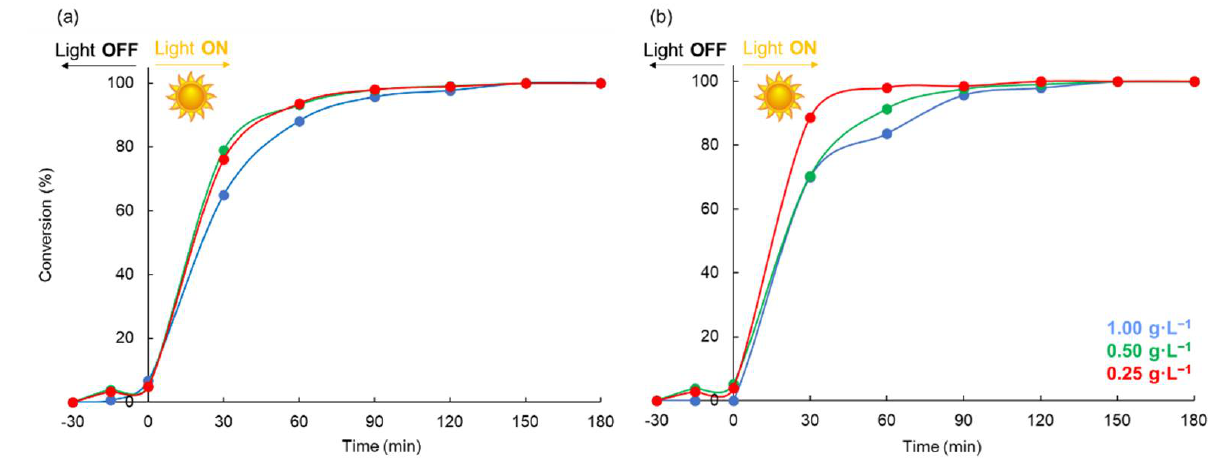
Figure 8. Effect of photocatalyst dose on DCF photodegradation in UW (( a ) STOn; ( b ) STOm). Dark adsorption tests led to a negligible DCF loss for both samples. In contrast, both